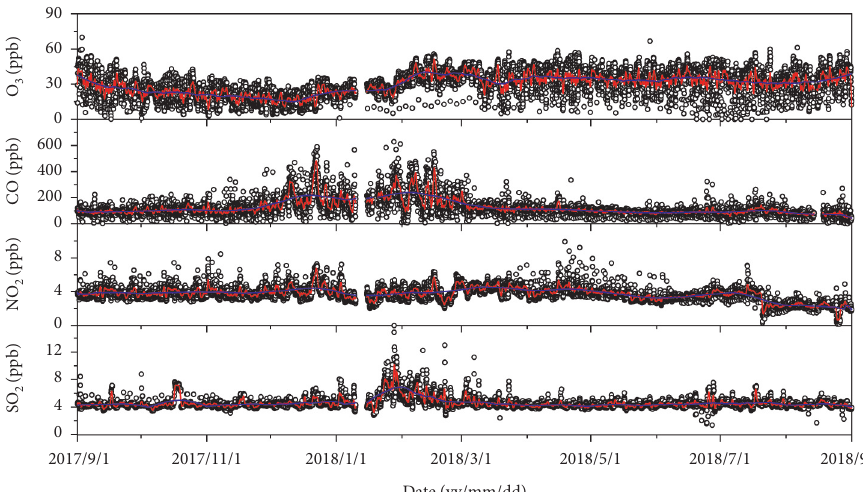
Figure 2: Time series changes in the hourly averages of O 3 , CO, NO 2 , and SO 2 on the ground during the observation period from September 2017 to August 2018. The black circle is the hourly average, the thin red line is the 24-hour smoothening, and the blue thick solid line is the 30-day smoothening.